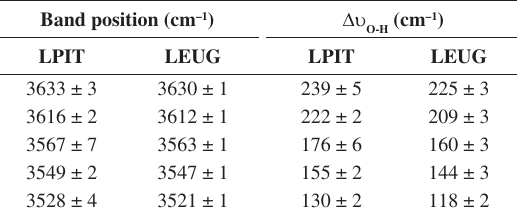
Table 5. Bands position and wavenumber shift for the lignin bands obtained from the second derivative of the FTIR spectra. Band position (cm –1 )